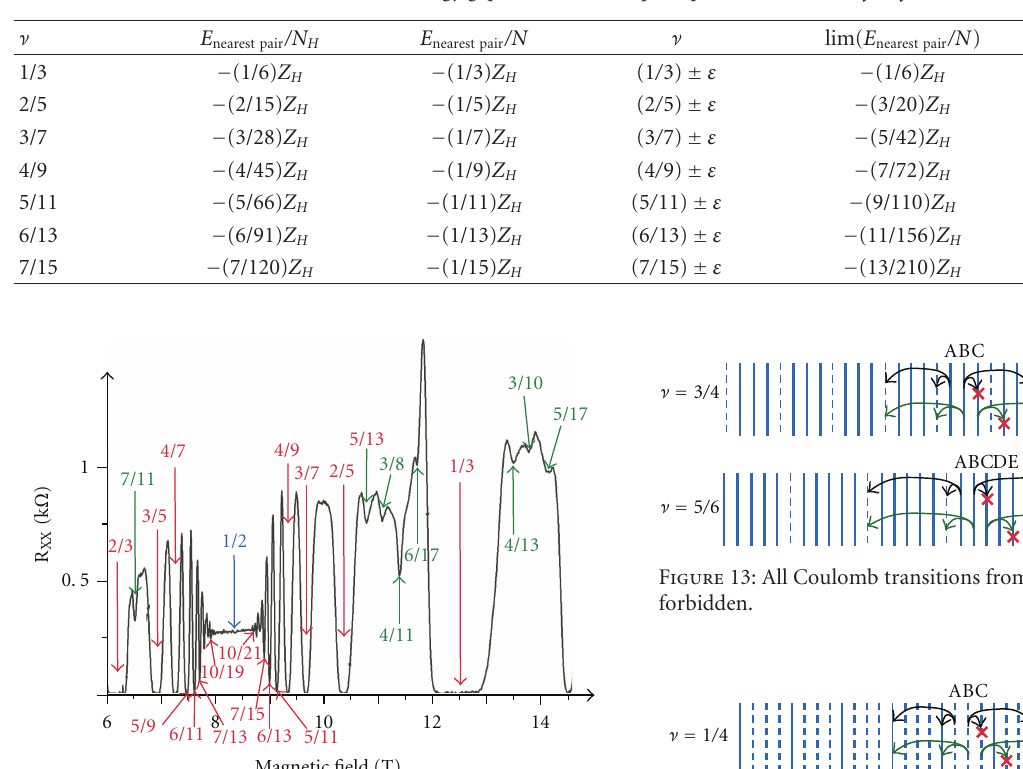
Table 2: Energy gaps of nearest hole pairs per electron at ν = j/ (2 j + 1).